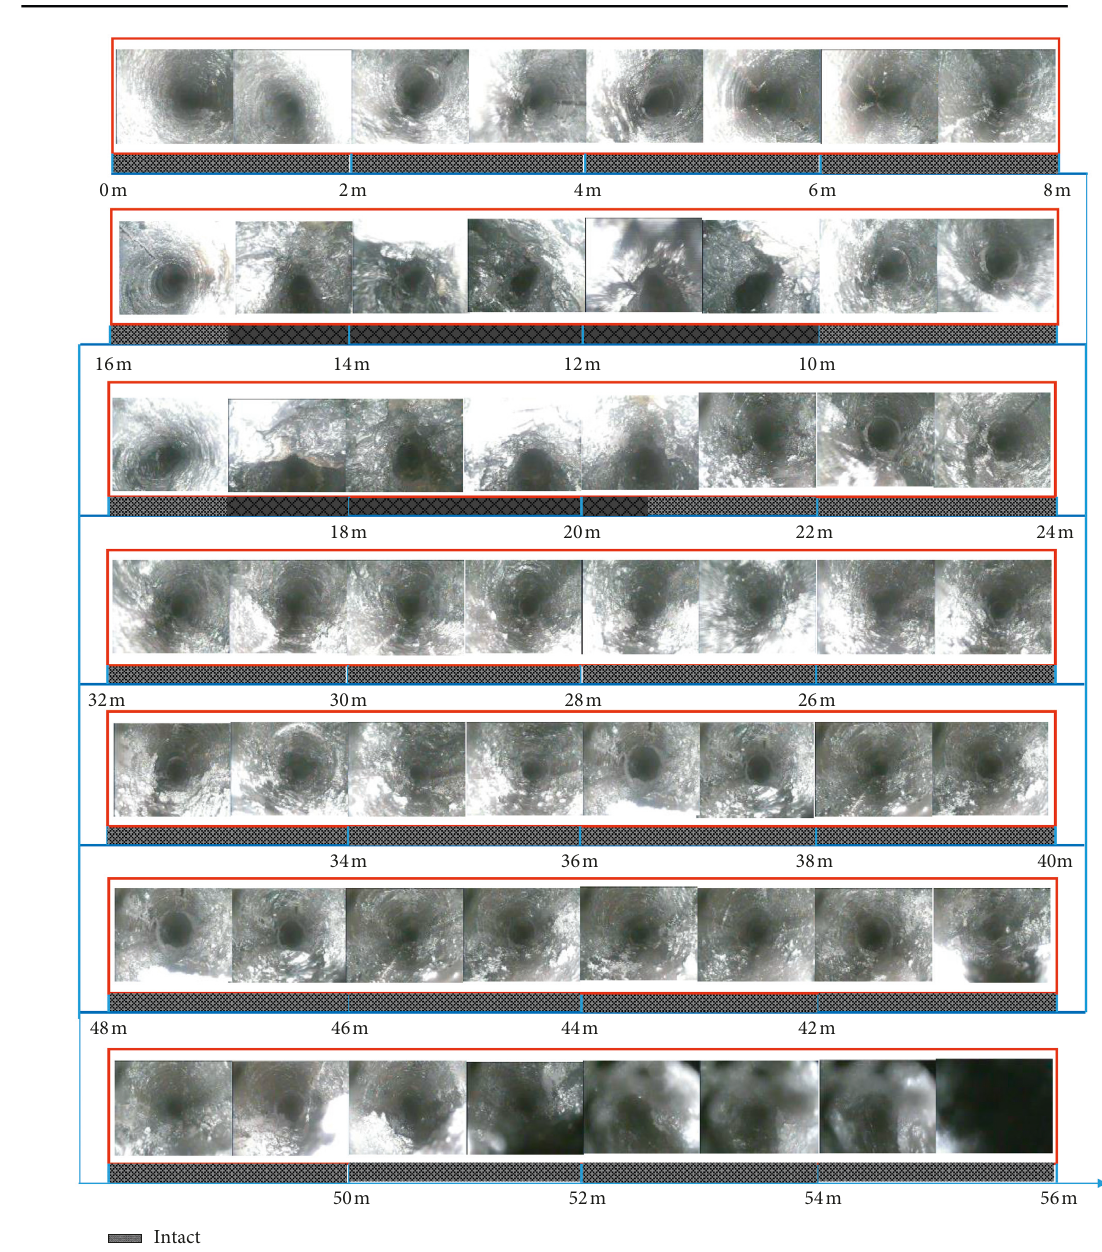
Figure 19: Photos of borehole No. 22 at different